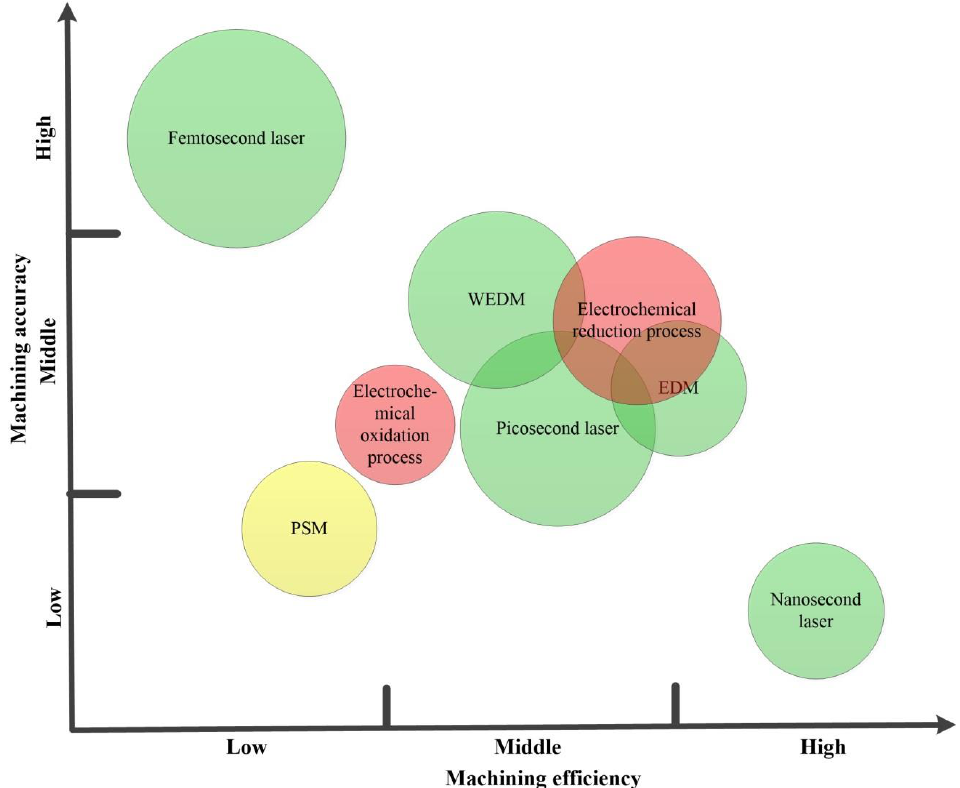
Figure 15. Comparison of machining efficiency, machining accuracy, machining cost, and environmental impact of different non-traditional machining methods for superhydrophobic surfaces. (The radius of the circle represents the machining cost; the larger the radius, the higher the cost. Moreover, the color of the circle represents the impact of manufacturing on the environment, while green, yellow, and red represent small, medium, and large impact on the environment).